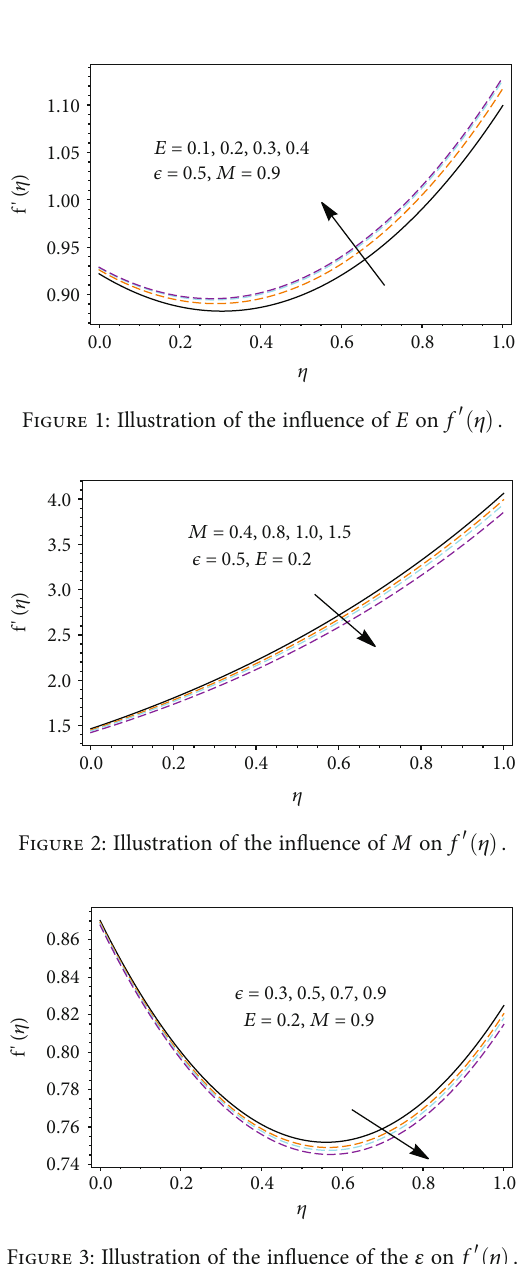
Figure 7: Illustration of the in fl uence of M on θ ð η Þ .